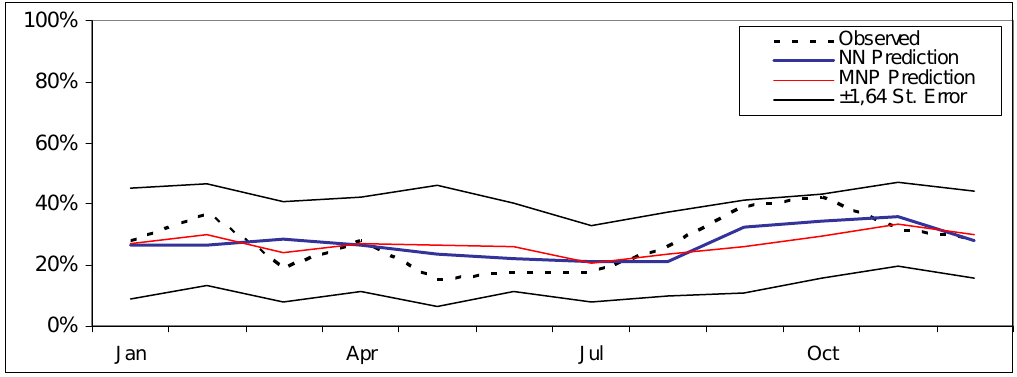
Figure 6 Predictions of Brand 2 monthly share of purchases within the holdout sample